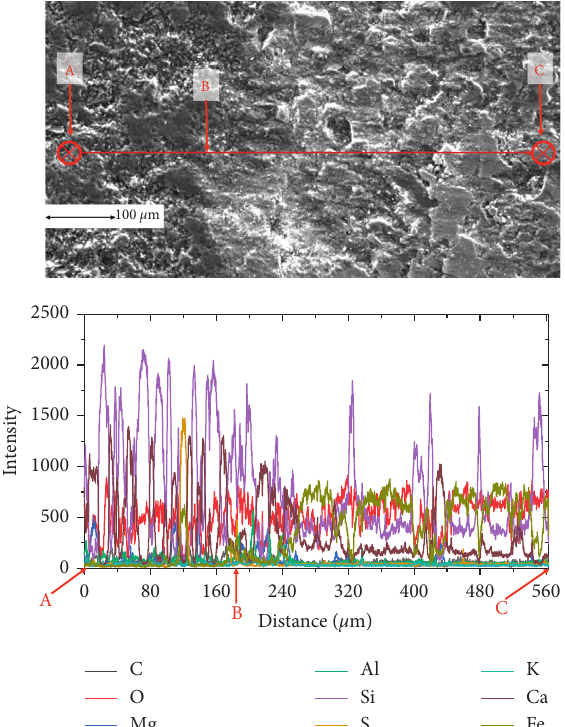
Figure 11: The material transfer between the steel ball and